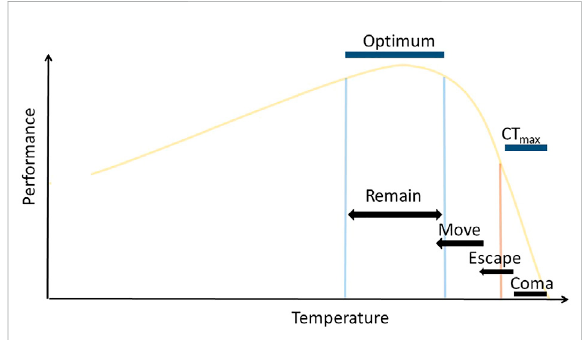
FIGURE 1 Theoretical thermal reaction norm for performance of a trait, highlighting the expected locomotory response of mobile marine ectotherms to increasing thermal exposure. Exposure to extreme temperatures above a threshold (orange line), for suf fi cient duration, will result in animals entering heat coma at CT max , losing the ability to escape lethal temperatures. Short duration exposure to temperatures above this threshold, or extended exposure to temperatures close to this threshold, are expected to illicit escape responses that will move individuals to cooler temperatures. Individuals exposed to temperatures above their optimum range are expected to also move to cooler temperatures and relocate within their optimal temperature range, where they will